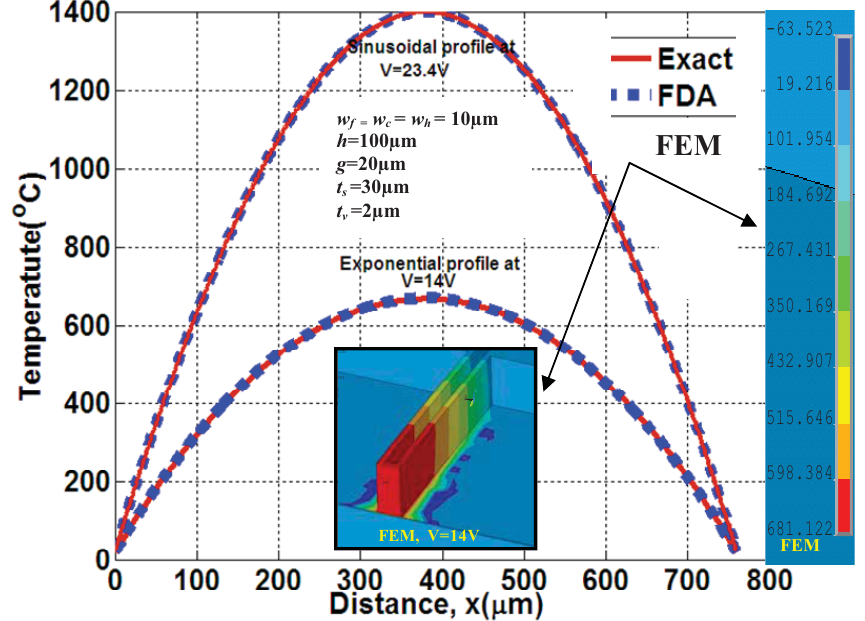
Figure 4. Simulations of the temperature profile in a single bent